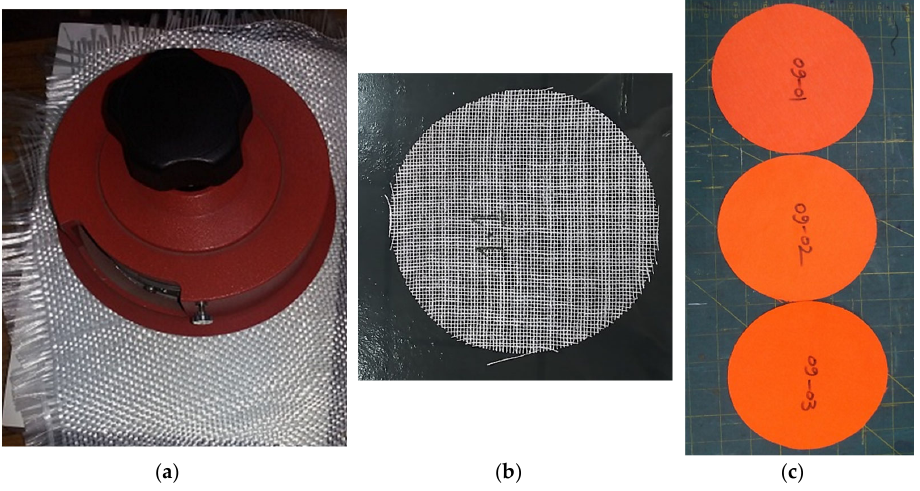
Figure 2. Fabric specimens for mass per unit area ( a ) fabric cutter ( b ) TF12 specimen ( c ) TF9 specimens for mass per unit area.